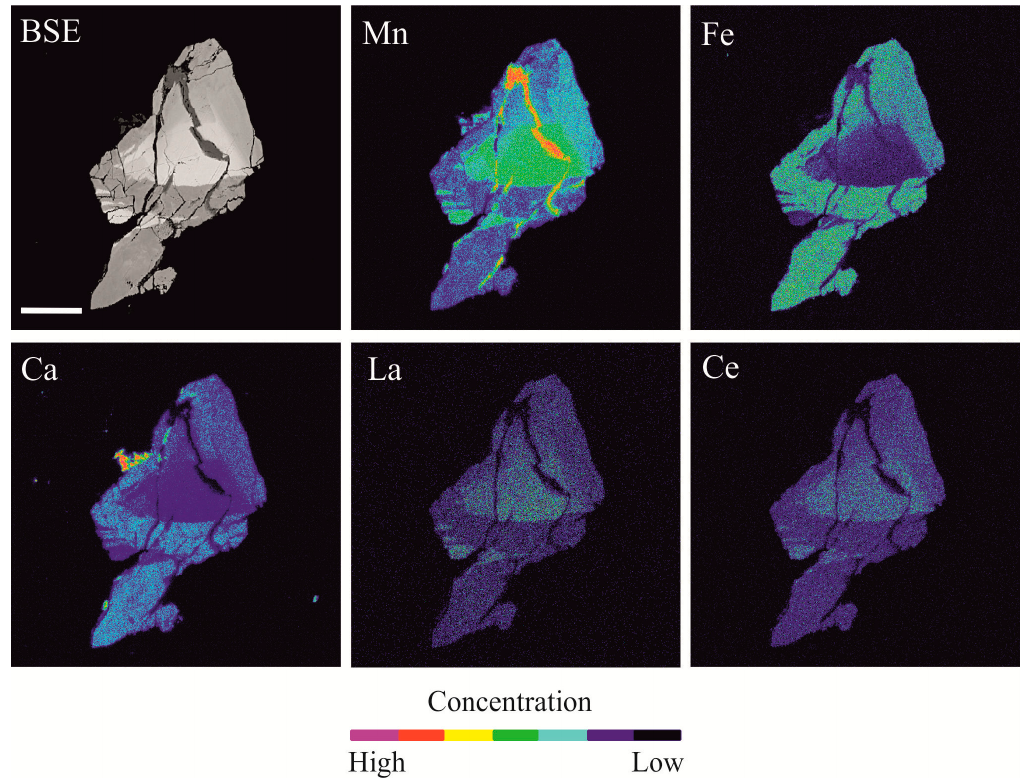
Figure 3. Back-scattered electron (BSE) image and X-ray maps of sample #19903-2, showing the distribution of Mn, Fe, Ca, La, and Ce. Scale bar = 50 μ m.